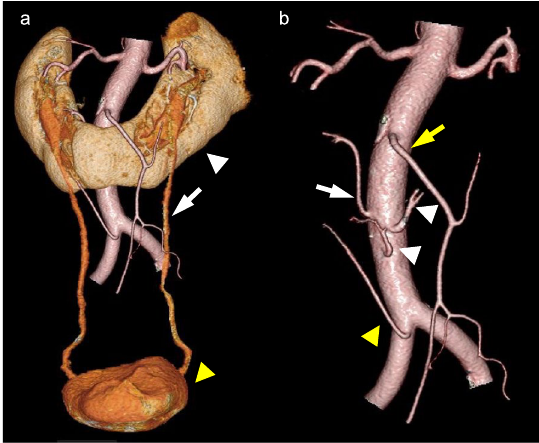
Fig. 2 Three-dimensional computed tomography imaging showing the horseshoe kidney and aberrant renal arteries. a The horseshoe kidney (white arrowhead), left ureter (white arrow), and bladder (yellow arrowhead). b The root of the aberrant renal arteries at the isthmus from the aorta (white arrowhead), right branch of the aberrant renal artery from the aorta (white arrow), right branch of the aberrant renal artery from the right common iliac artery (yellow arrowhead), and inferior mesenteric artery (yellow arrow)